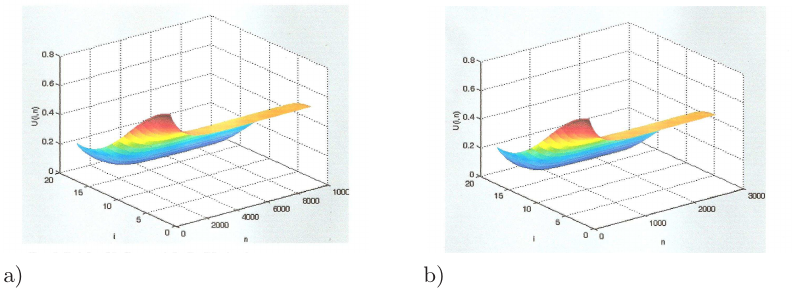
Figure 1. Evolution of the discrete solution: a) Implicit scheme, b) Explicit